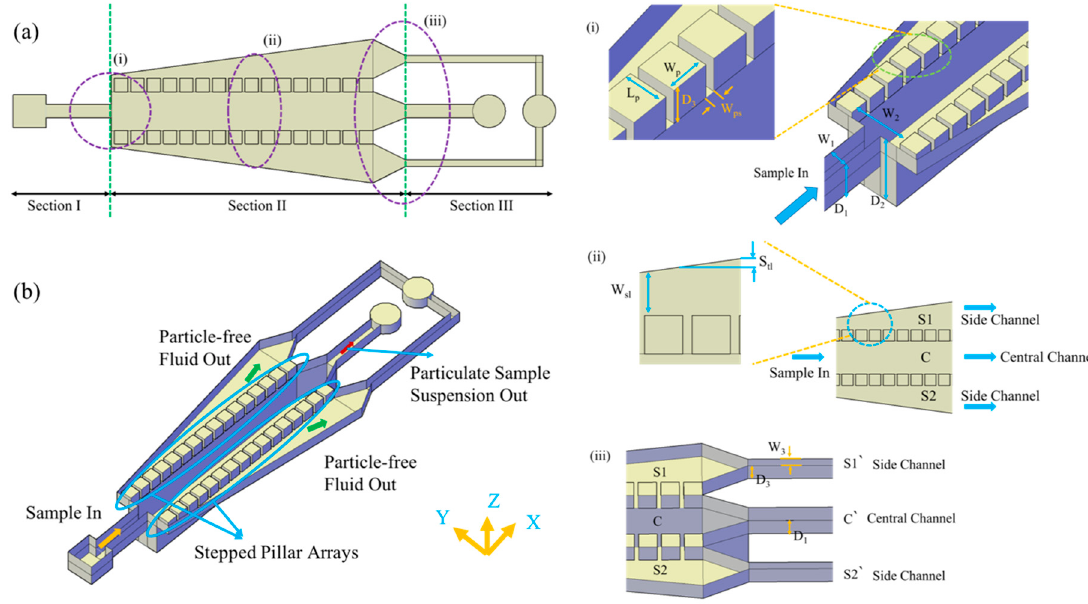
Figure 1. Schematics representing the proposed decantation device. ( a ) Schematic of the proposed microfluidic device. ( b ) An isometric view of the device schematic to better visualize the features. ( i ), ( ii ), and ( iii ) represent the representative schematic images at the appropriate locations.